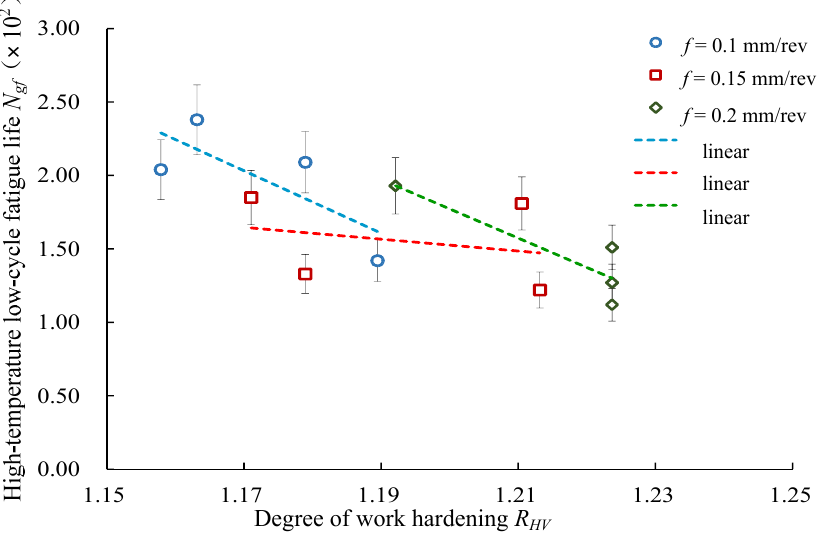
Figure 11. Effects of work hardening on low-cycle fatigue life.